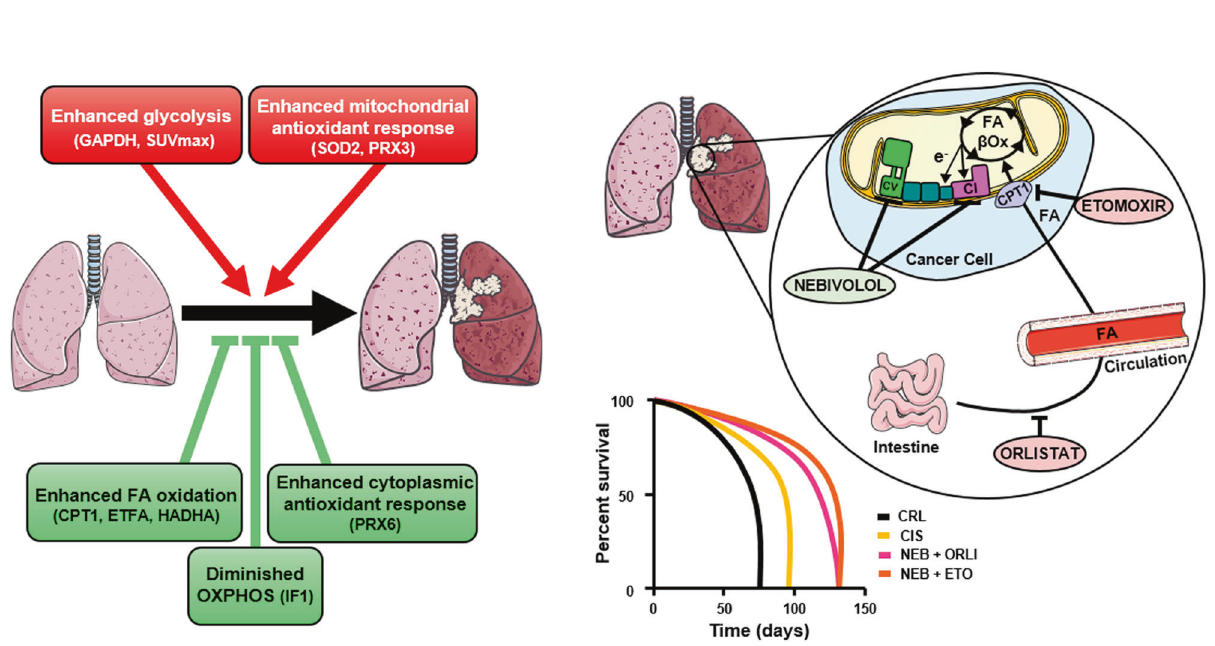
Fig. 7 Graphical abstract and highlights. The metabolic pro fi le of LUAD provides biomarkers of prognosis and for targeted therapies. The schematic summarizes the main metabolic signatures involved in LUAD progression. On the top (in red), an enhanced glucose uptake (SUVmax), glycolysis (GAPDH) and mitochondrial antioxidant response (SOD2, PRX3) are markers of bad prognosis for the patients. Below (in green), an enhanced fatty acid oxidation (CPT1, ETFA, HADHA) and cytoplasmic antioxidant response (PRX6) are markers of good prognosis. Likewise, a reduced OXPHOS (IF1) also predicts good prognosis for LUAD patients. The representation highlights the prominent role of FA β -oxidation and mitochondrial OXPHOS as targets for effective and less noxious therapy of LUAD. Orlistat (pink) inhibits gastrointestinal lipases restraining the uptake of FA into the circulation. Etomoxir (pink) inhibits CPT1 preventing the import of FA into mitochondria. Both orlistat and etomoxir prevent β -oxidation of FA and the supply of electrons to the respiratory chain. Nebivolol (light green) is a β 1-adrenergic blocker that inhibits OXPHOS at complexes I (red) and V (ATP synthase) (green) generating a metabolic and redox crisis in cancer cells. The combination of metabolic inhibitors targeting mitochondrial activities are better tolerated and signi fi cantly increase lifespan of mice bearing LUAD when compared to cisplatin summary of relevant clinicopathological information, including the maximum standardized uptake value (SUVmax) obtained in [18 F] FDG positron-emission tomography (PET) scans for some of the patients in the cohort, is provided in Supplementary Table S1. Frozen tissue sections were homogenized in Tissue Protein Extraction Reagent (T-PER) (Cat. No. 78510, Thermo Scienti fi c, Ins. Madrid, Spain) supplemented with EDTA-free protease inhibitor cocktail (Complete Mini, MilliporeSigma, Burlington, Massachusetts, USA) and phosphatase inhibitor cocktail-2 (MilliporeSigma) in a 1:5 (w/v) ratio, and further freeze thawed three times in liquid nitrogen. Protein concentration was determined with Bradford reagent